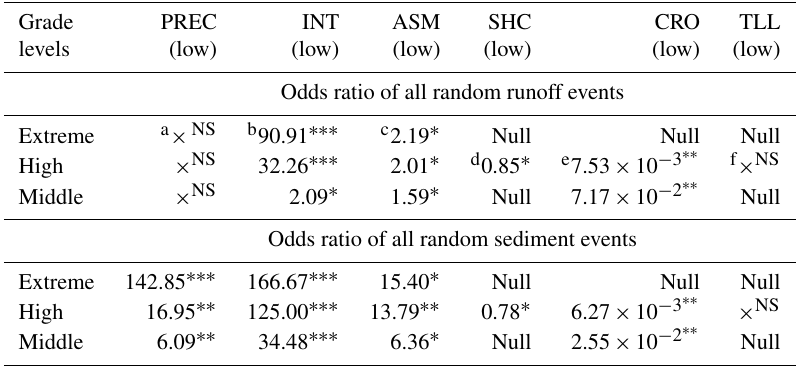
Table 6. Logistic regression model to analyse the single effect of rainfall, plant and soil ordinal variable on the erosion events pres- ence/absence in all restoration vegetation types.